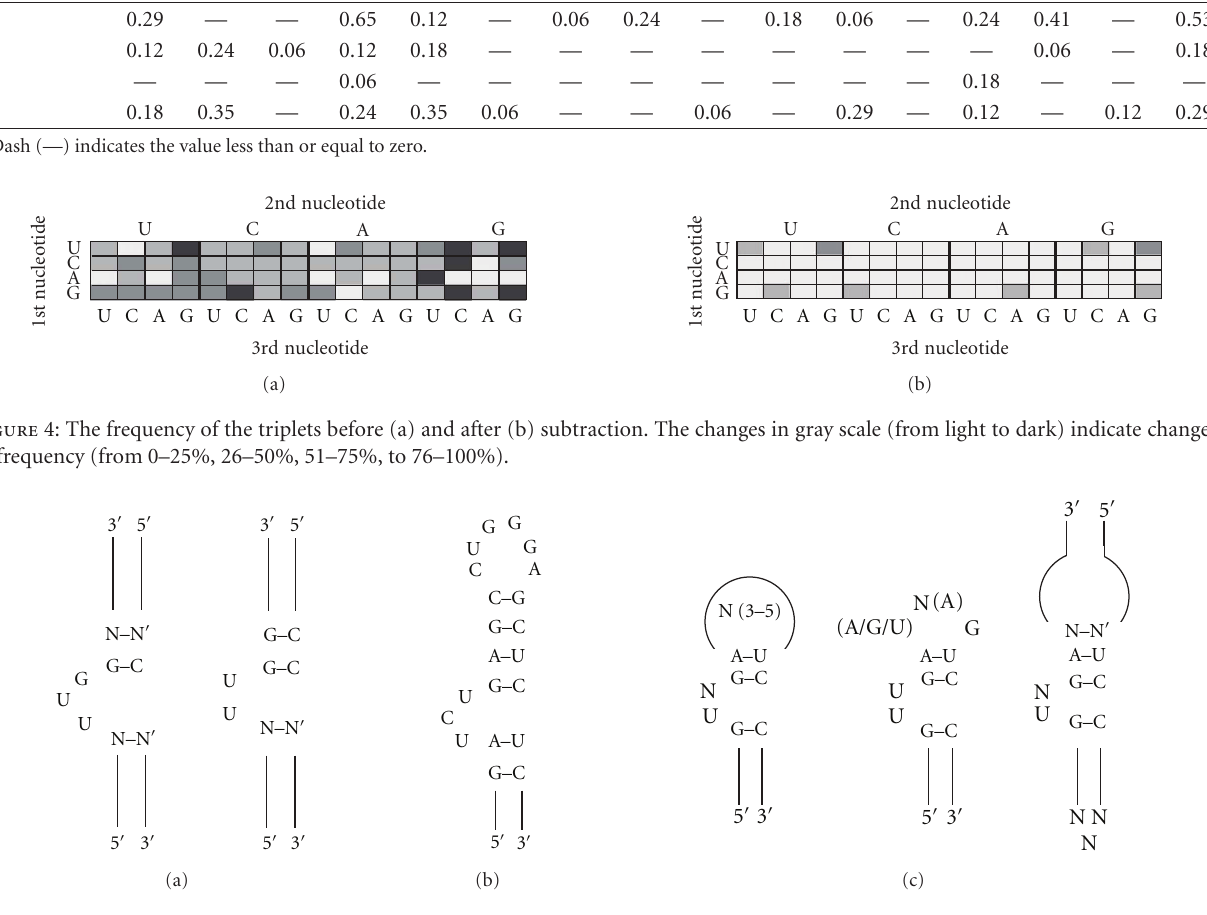
Figure 5: Secondary structures of Tat and/or arginine binding RNAs. (a) UUGG motif obtained in the present study. (b) Tat-binding motif of TAR [12]. (c) Several motifs of arginine aptamers from in vitro selection experiments